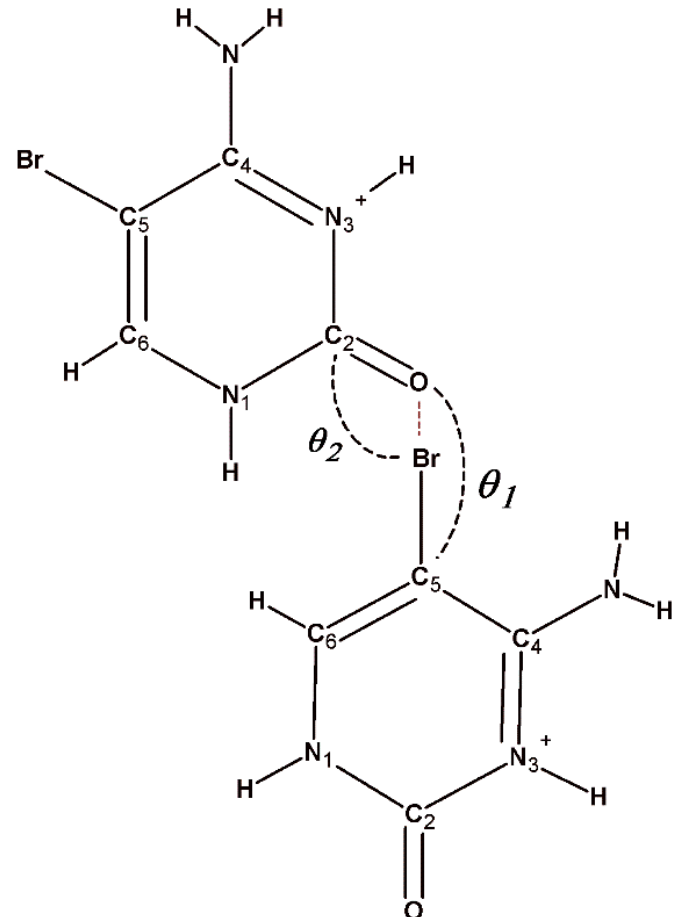
Figure 12. Schematic showing angles defining the approach of the lp acceptor towards the lp donor ( θ 1 ) and the lp donor towards the lp acceptor ( θ 2 ).